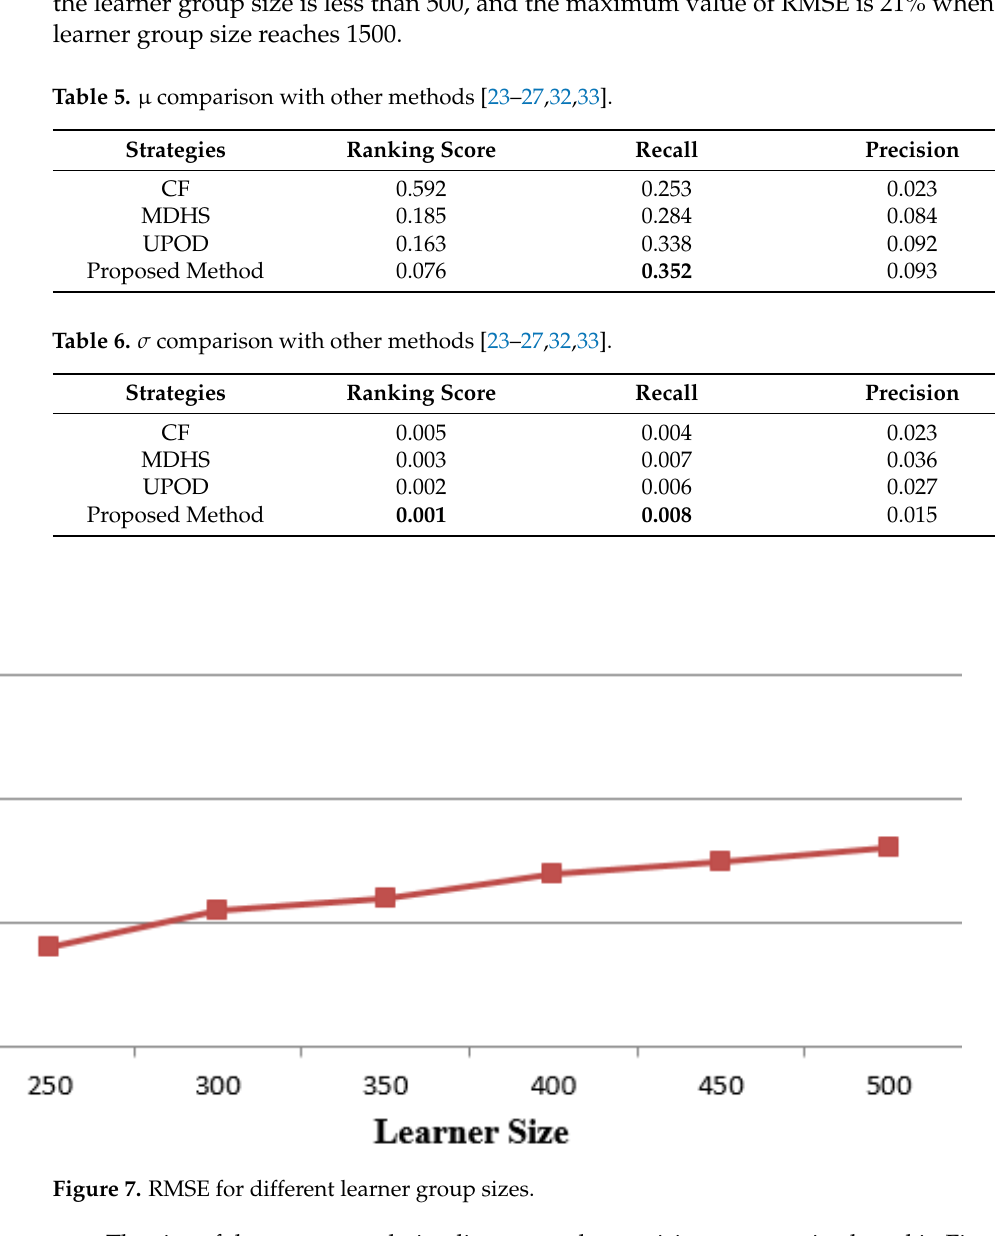
Figure 8. Size of the recommendation list versus precision.